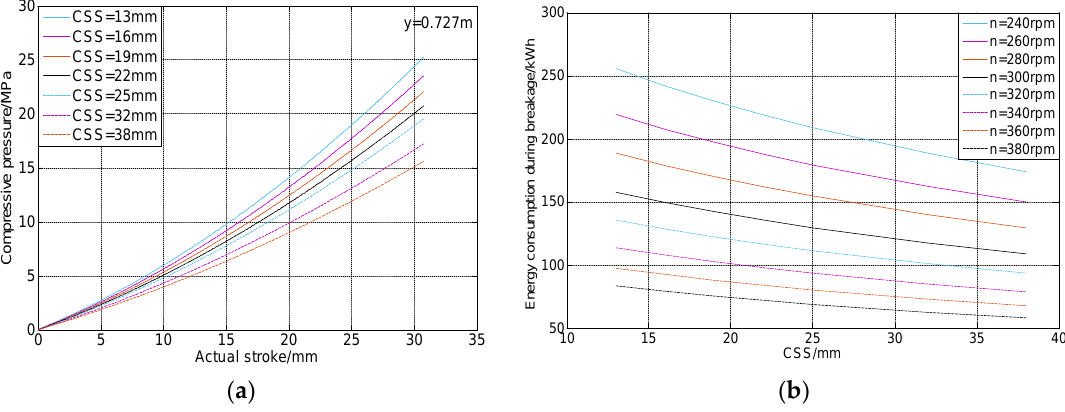
Figure 13. Relation of CSS and energy consumption: ( a ) CSS vs. energy consumption; ( b ) CSS, production and energy consumption. Figure 12. The influence of CSS on pressure and breakage energy: ( a ) relation of CSS vs. pressure; ( b ) relation of CSS vs. breakage energy consumption.